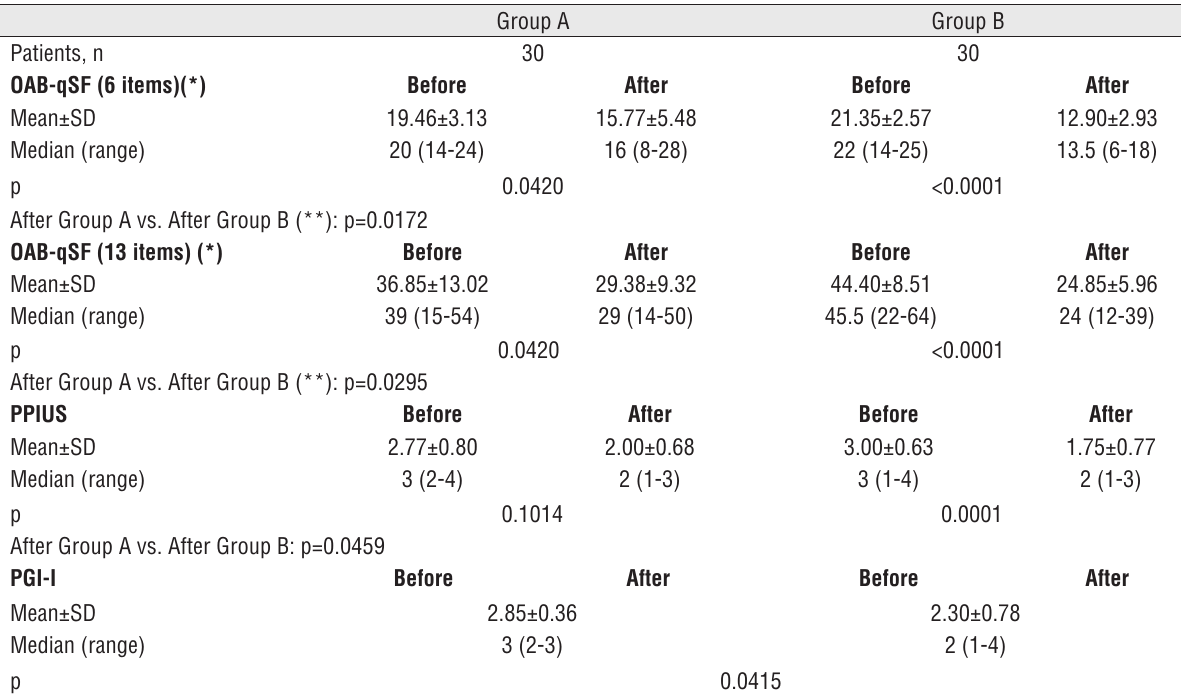
Table 2 - Overactive Bladder questionnaire Short Form (OAB-qSF), Patient Perception of Intensity of Urgency Scale (PPIUS) and Patient Global Impression of Improvement questionnaire